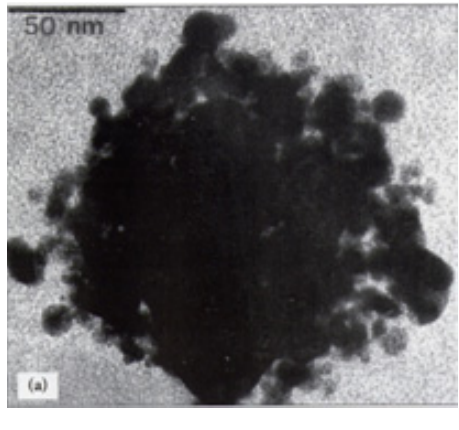
Figure 2. TEM image of Au/AC prepared by DP